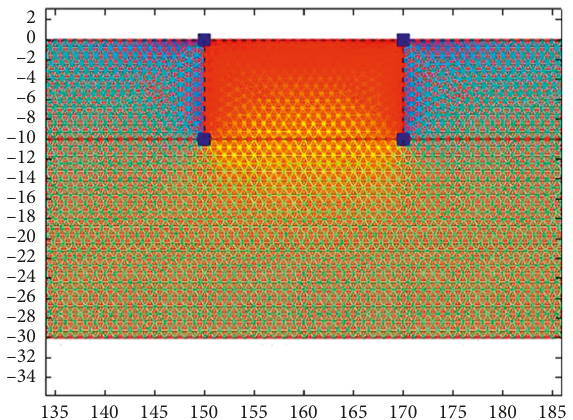
Figure 8: Meshing diagram of the Ge mesa region.